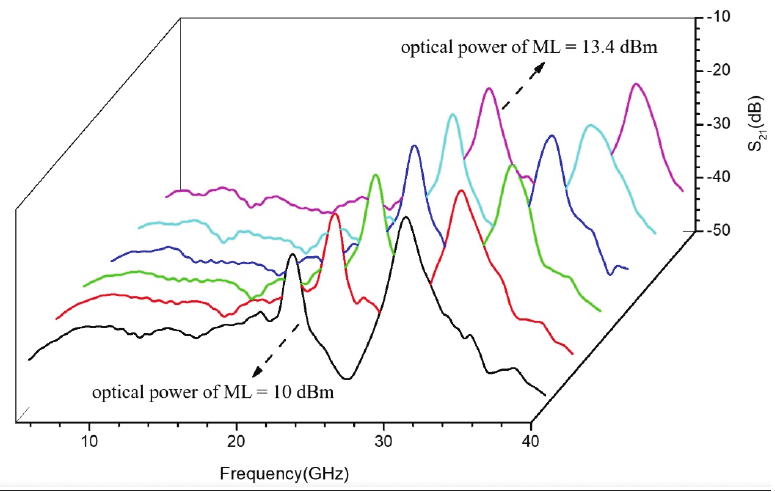
Figure 5. Results of the tunability of the dual-passband MPF by adjusting the optical power of ML from 10 to 13.4 dBm. (cid:3)